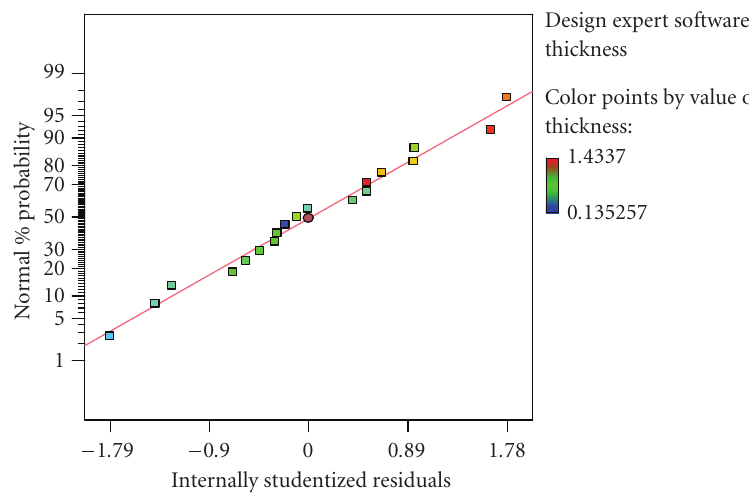
Figure 6.1 . Normal probability plot of residuals for chip thickness data.